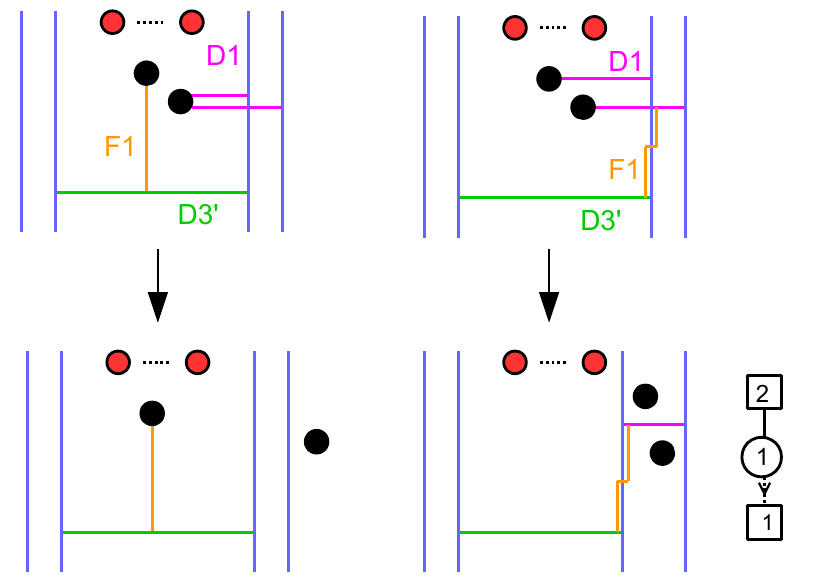
Figure 15 . Two brane setups contributing to h U +